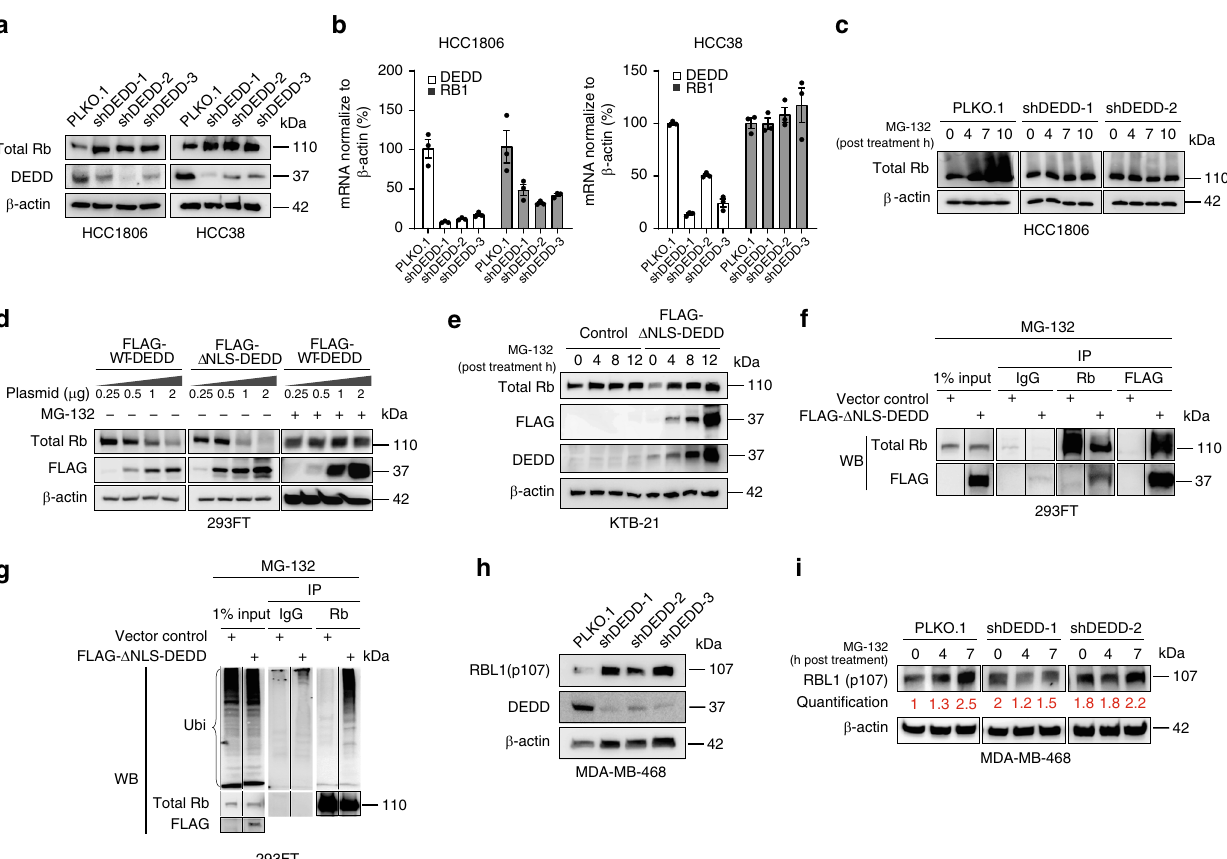
Fig. 4 Cytosolic death effector domain-containing DNA-binding protein ( DEDD ) promotes retinoblastoma (Rb)/p107 proteasome degradation. a Western blots show Rb protein expression levels 6 h after abolishing synchronization by fetal bovine serum (FBS) in DEDD knockdown triple-negative breast cancer (TNBC) cell lines (HCC1806, HCC38, Rb intact). b Quantitative PCR showing both DEDD and Rb1 gene expression in DEDD- knockdown TNBC cell lines. c Western blots showing Rb protein expression in DEDD -knockdown HCC1806 cells under the MG-132 (proteasome inhibitor) treatment for indicated hours. d Western blots showing Rb protein expression levels in the 293FT cells treated with different dosages of 3×-FLAG-WT- DEDD - or 3×-FLAG- Δ NLS- DEDD -expressing plasmids with or without MG-132 treatment. e Western blots showing Rb protein expression levels in KTB-21 cells with or without the overexpression of cytosolic DEDD under the treatment of MG-132. f Immunoprecipitation assay showing the interaction between cytosolic DEDD and Rb protein after overexpressing 3×-FLAG- Δ NLS- DEDD in 293FT cells. g Immunoprecipitation assay showing Rb protein ubiquitination level after co- transfection of HA-ubiquitin and 3×-FLAG- Δ NLS- DEDD in 293FT cells. h Western blots showing Rb protein expression levels 6 h after abolishing synchronization by FBS in DEDD -knockdown TNBC cell lines (MDA-MB-468, Rb de fi cient). i Western blots showing Rb protein expression in DEDD - knockdown MDA-MB-468 cells under MG-132 treatment for indicated hours. All quantitative data were generated from a minimum of three replicates. P values were derived from one-way analysis of variance (ANOVA) with multiple comparison test. Error bars represent means ±